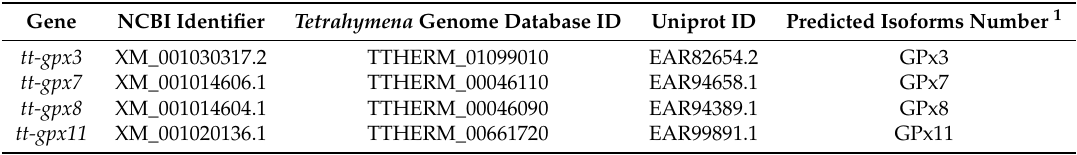
Table 1. List of putative sequences confirmed by cloning and sequencing and the associated IDs across Tetrahymena Genome Database, NCBI (RefSeq) and UniProt (UniRef)